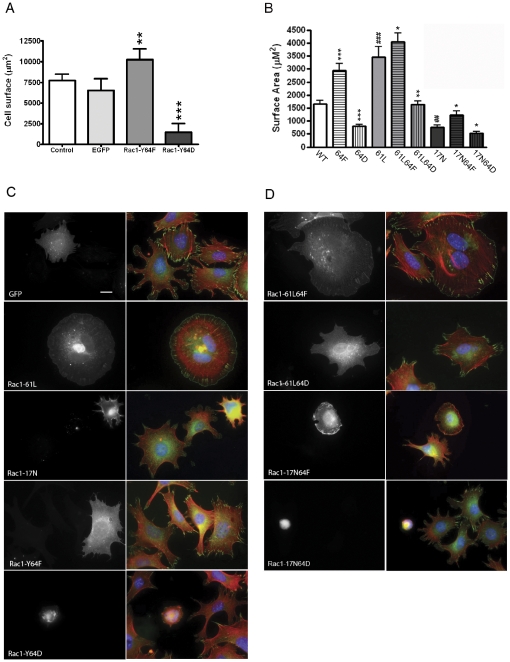
Rac1-Y64 phosphorylation modulated cell spreading.(A) Transfected HUVEC were plated onto fibronectin-coated coverslips for 90 minutes and then fixed and permeabilized for immunofluorescence staining. Rhodamine-phalloidin labeled EGFP-positive cells were used for cell surface area quantification using Openlab software. Data are shown as mean±SEM, and were as follows: non-transfected HUVEC controls had a mean surface area of 7760 µm2 (± 730.5, n = 28), and the mean area was 6510 µm2 (±1433.0, n = 8) for EGFP-transfected cells. A large increase in spread surface area to 10246 µm2 (±1310, n = 14) was noted in EGFP-Rac1-Y64F-transfected HUVEC, and cells expressing EGFP-Rac1-Y64D had a greatly reduced mean surface area of 1480 µm2 (±1037, n = 5). ** indicates p <0.001, and *** denotes p < 0.0001 for the designated population as compared with the EGFP control. (B) Cell surface area was quantified from phalloidin-labeled MEF images using Openlab software in cells transfected with EGFP-Rac1-WT, EGFP-Rac1-Y64F, EGFP-Rac1-Y64D, EGFP-Rac1-61L, EGFP-Rac1-61L/64F, EGFP-Rac1-61L/64D, EGFP-Rac1-17N, EGFP-Rac1-17N/64F, or EGFP-Rac1-17N/64D. Data are shown as the mean±SEM. * denotes p < 0.05, ** means p <0.001, and *** is p < 0.0001 when data from groups transfected with Y64F or Y64D are compared with values from the corresponding controls (e.g. EGFP-Rac1-WT, EGFP-61L, or EGFP-17N, respectively, without the mutations at position 64). ## denotes p<0.005, while ### denotes p<0.0001 when data from 61L or 17N mutants were compared with wild-type. Quantitative cell spreading data and the number of MEF studied in each group are detailed in Table 1. (C) MEF were transfected with EGFP, or EGFP-tagged Rac1 single mutants. Two days after transfection, cells were seeded onto fibronectin-coated coverslips for two hours and prepared for immunofluorescence analysis. Cells were labeled with DAPI, rhodamine-phalloidin and anti-vinculin (followed by Cy5). Transfected GFP-positive cells are shown indicated in black and white, while the composite images display merges of combined DAPI (blue), phalloidin (red) and vinculin (green) labeling. Scale bar denotes 20 µm. (D) MEF that had been transfected with the EGFP-tagged Rac1 double mutants including Rac1-61L/64F, -61L/64D, -17N/64F, or -17N/64D were plated on fibronectin-coated coverslips and labeled for IF analysis as describe for panel 2C. Scale is the same as panel 2C.